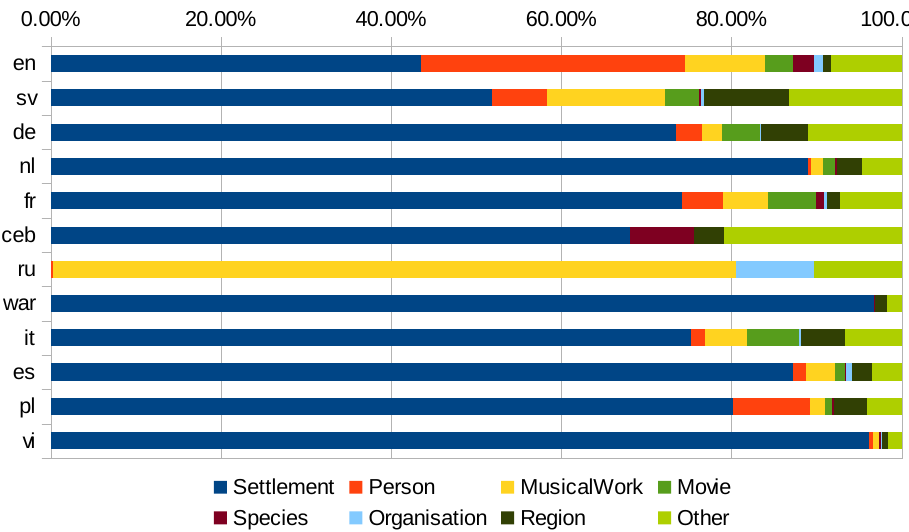
Figure 6. Distribution of relations in the different language extractions.